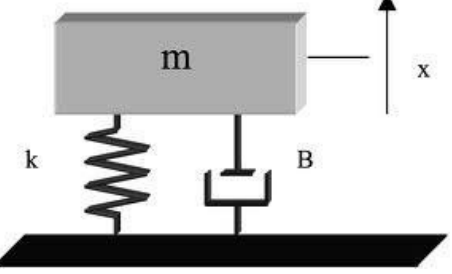
Figure 1: Dynamic model of basic accelerometer